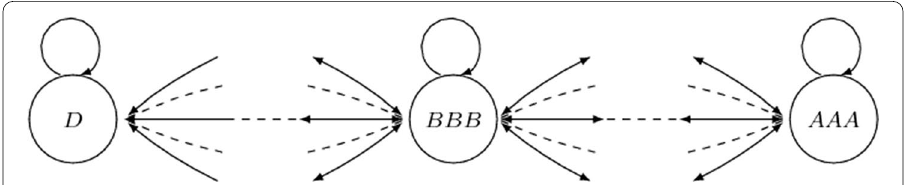
Fig. 2 State transition diagram for a MRGP model with catastrophe for credit rating dynamics. Here, the state space is { AAA , AA , A , BBB , BB , B , C , D } , where D denotes the default, an absorbing